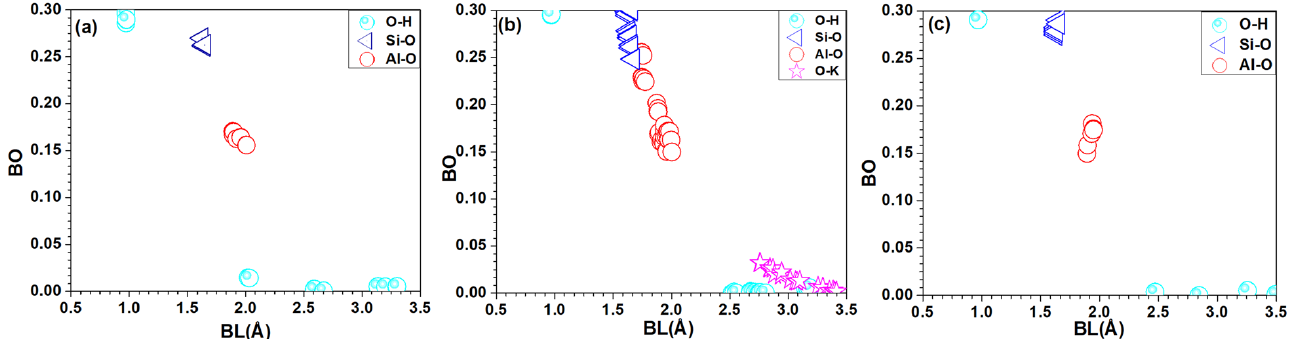
Figure 4. BO vs. BL of three clay mineral crystals for ( a ) kaolinite, ( b ) muscovite, and ( c ) montmorillonite.